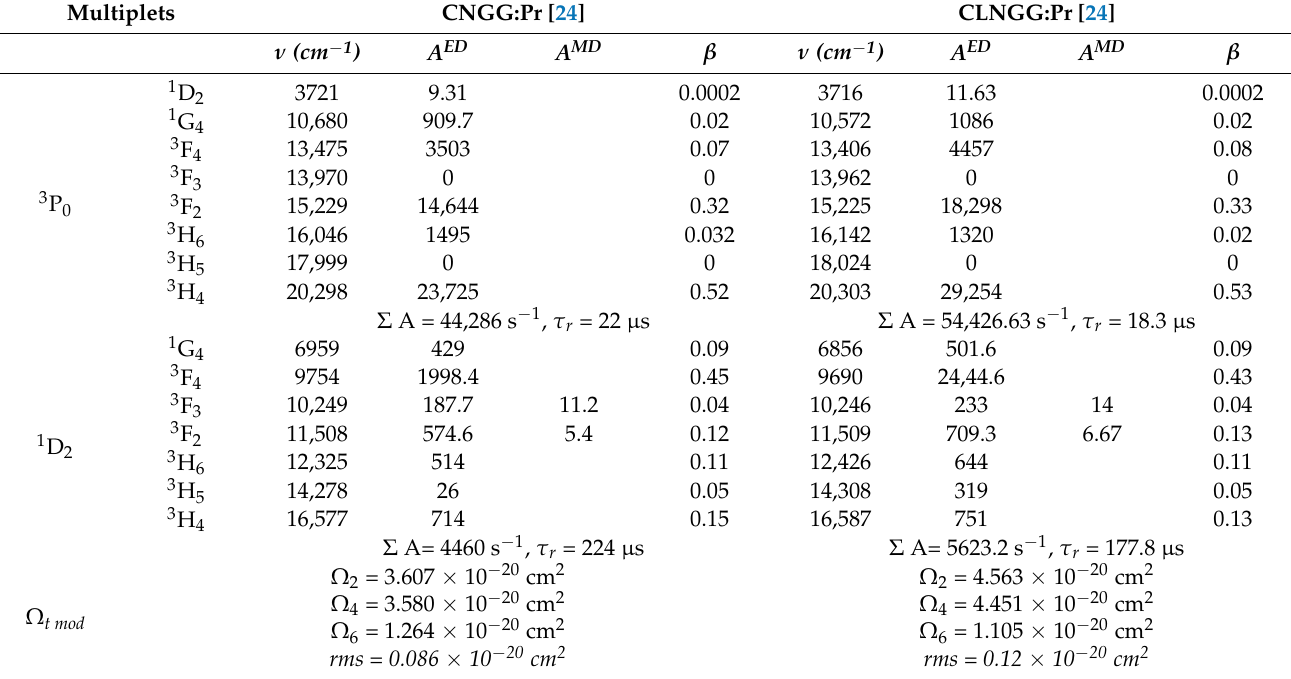
Table 11. Spontaneous emission probabilities ( A JJ’ ), branching ratios ( β JJ’ ), and radiative lifetimes ( τ r ) of the 3 P 0 and 1 D 2 excited levels of Pr 3+ ions in CNGG:Pr and CLNGG:Pr crystals.